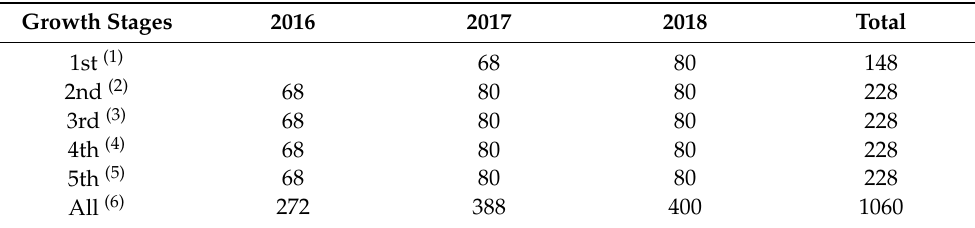
Table 1. Different growth stages of the samples used in this